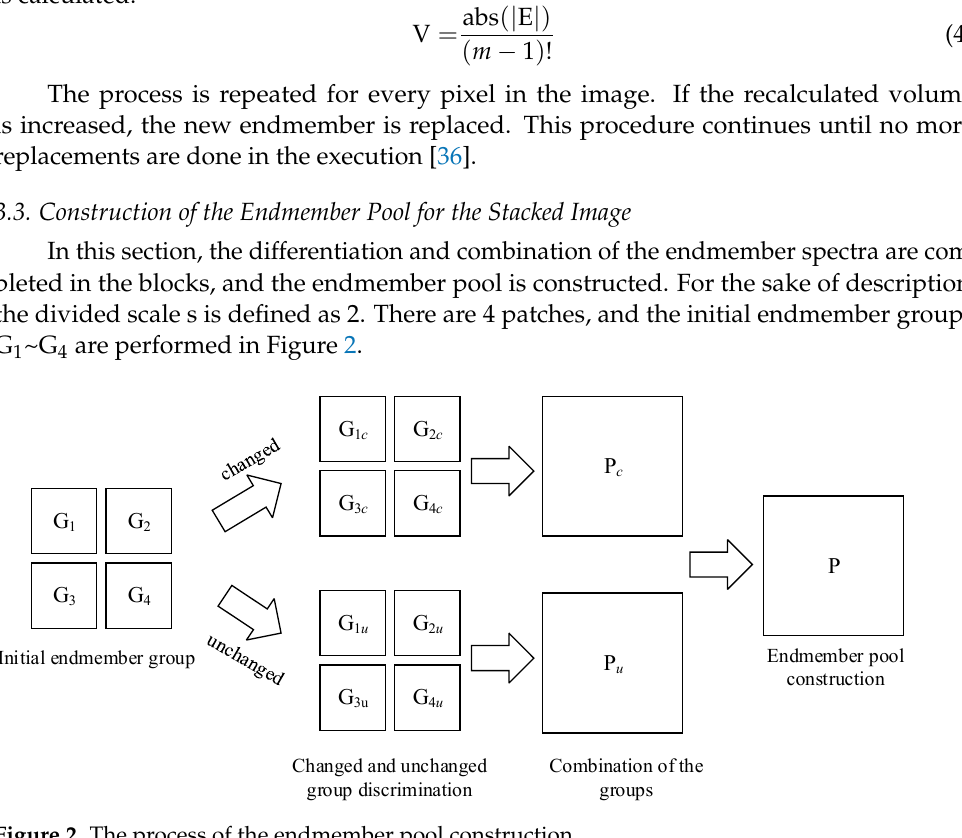
Figure 2. The process of the endmember pool construction.